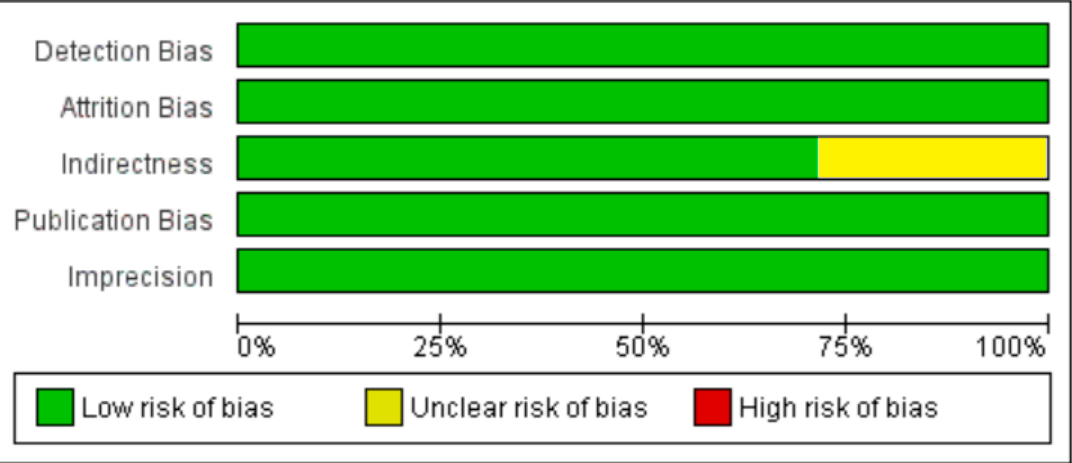
Figure 13. Summary of risk of bias assessment for diabetic subject studies: data shown are in per- centages.